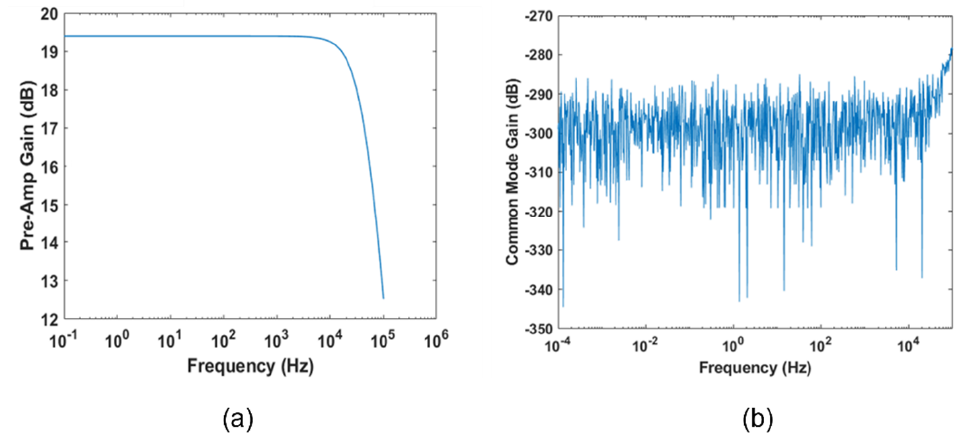
Figure 4. Simulations of the differential stage performed on LT Spice: ( a ) Differential gain; ( b ) common−mode gain.